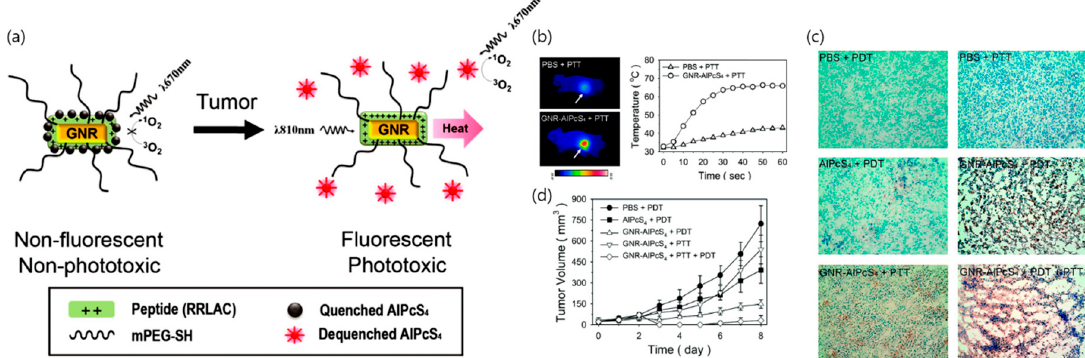
Figure 3. In vivo PTT and PDT. ( a ) The PEG-gold nanorod-RRLAC/Al(III) phthalocyanine chloride tetrasulfonic acid (GNR-AlPcS 4 ) complex for NIR fluorescence imaging and tumor phototherapy; ( b ) Thermographic images captured after 1 min of light illumination, and thermographic monitoring in the tumors of GNR-AlPcS 4 -injected and PBS-injected mice; ( c ) TUNEL staining of the tissue sections (magnification × 20). Normal or apoptotic cell nuclei are shown in green and brown, respectively. Empty areas in the tissue sections (GNR-AlPcS 4 complex + PDT and GNR-AlPcS 4 complex + PTT + PDT) are due to washout of the destroyed tumor cells during the staining procedure; ( d ) Tumor size in each treatment group by the indicated days. Points, mean; bars, standard deviation. PBS + PDT ( n = 7), free AlPcS 4 + PDT ( n = 7), GNR − AlPcS 4 complex + PDT ( n = 7), GNR-AlPcS 4 complex + PTT ( n = 5), GNR-AlPcS 4 complex + PTT + PDT ( n = 7), n = number of tumors involved. Reproduced from [110],